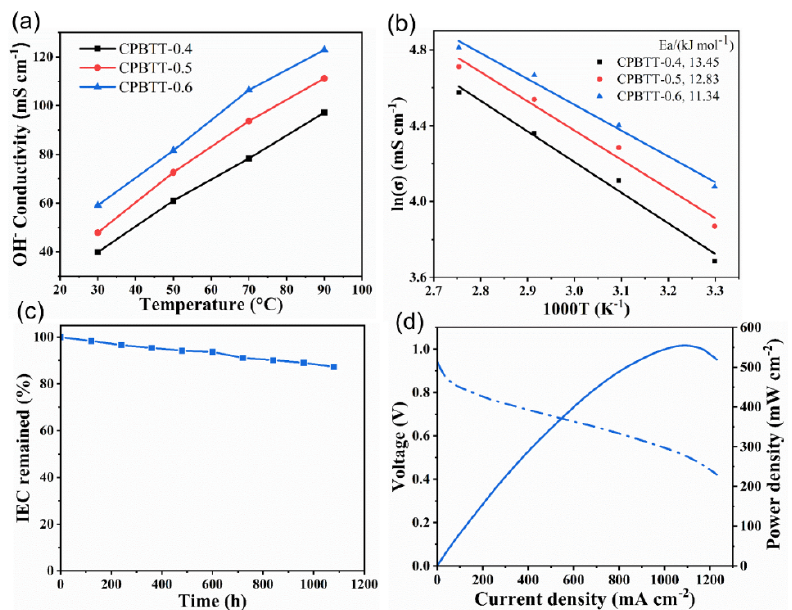
Figure 5. ( a ) OH − conductivity CPBTT − x AEMs as a function of temperature. ( b ) Arrhenius plots of the CPBTT − x AEMs. ( c ) changes in the IEC value of the CPBTT − 0.6 AEMs during the durability testing (1 M NaOH at 80 ◦ C for 1080 h). ( d ) the AEMFCs performance of the CPBTT − 0.6